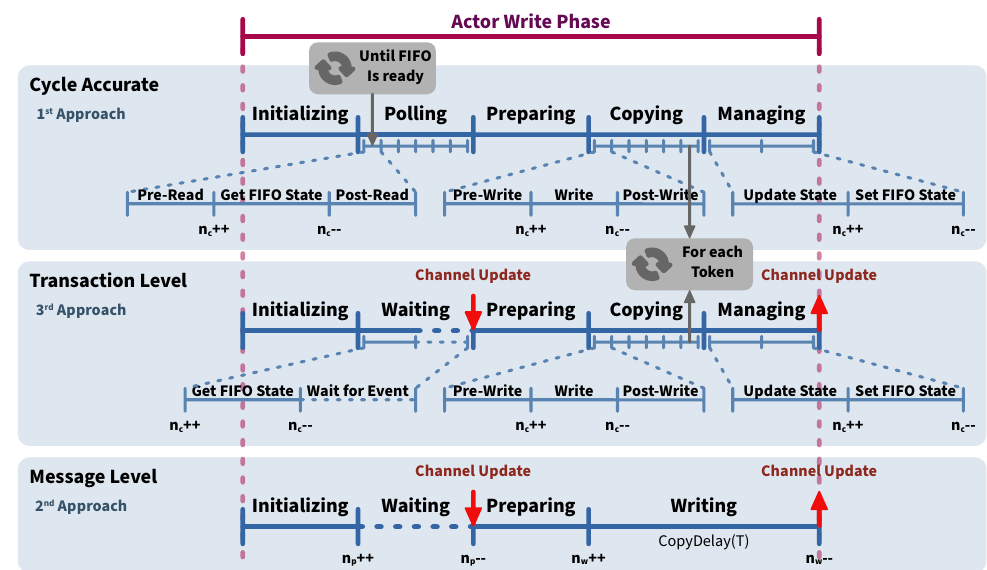
Figure 4. Simulation steps of the model of an actor write phase using two different communication models. cycle accurate [5] model at the top, message level [6] at the bottom and new transaction level model in the